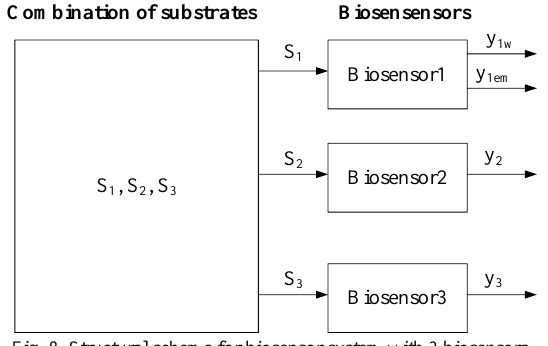
Fig. 8. Structural scheme for biosensor system with 3